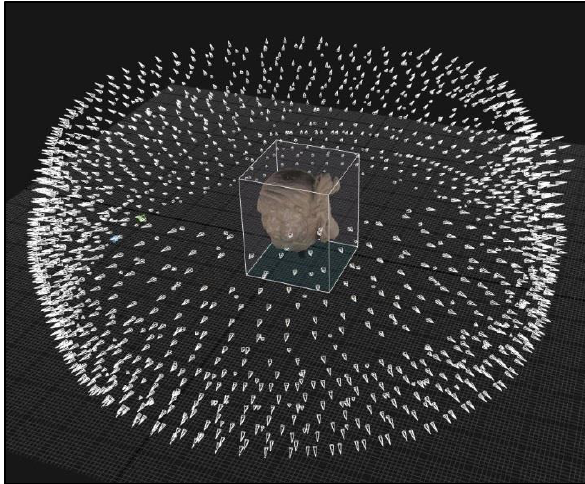
Figure 12. Camera alignment of the 90mm lens Focusing times were significantly longer as the zoom lens hunts alignment, seen in Figure 12.